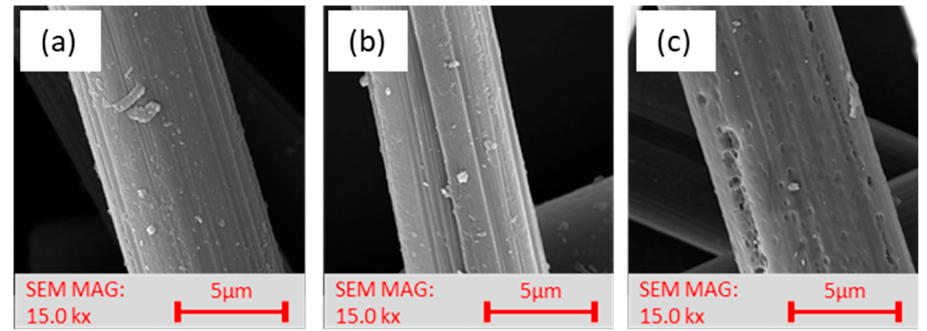
Figure 1. SEM photos of RCF: ( a ) without treatment; ( b ) MW plasma-treated for 1 min; and ( c ) MW plasma-treated for 10 min.